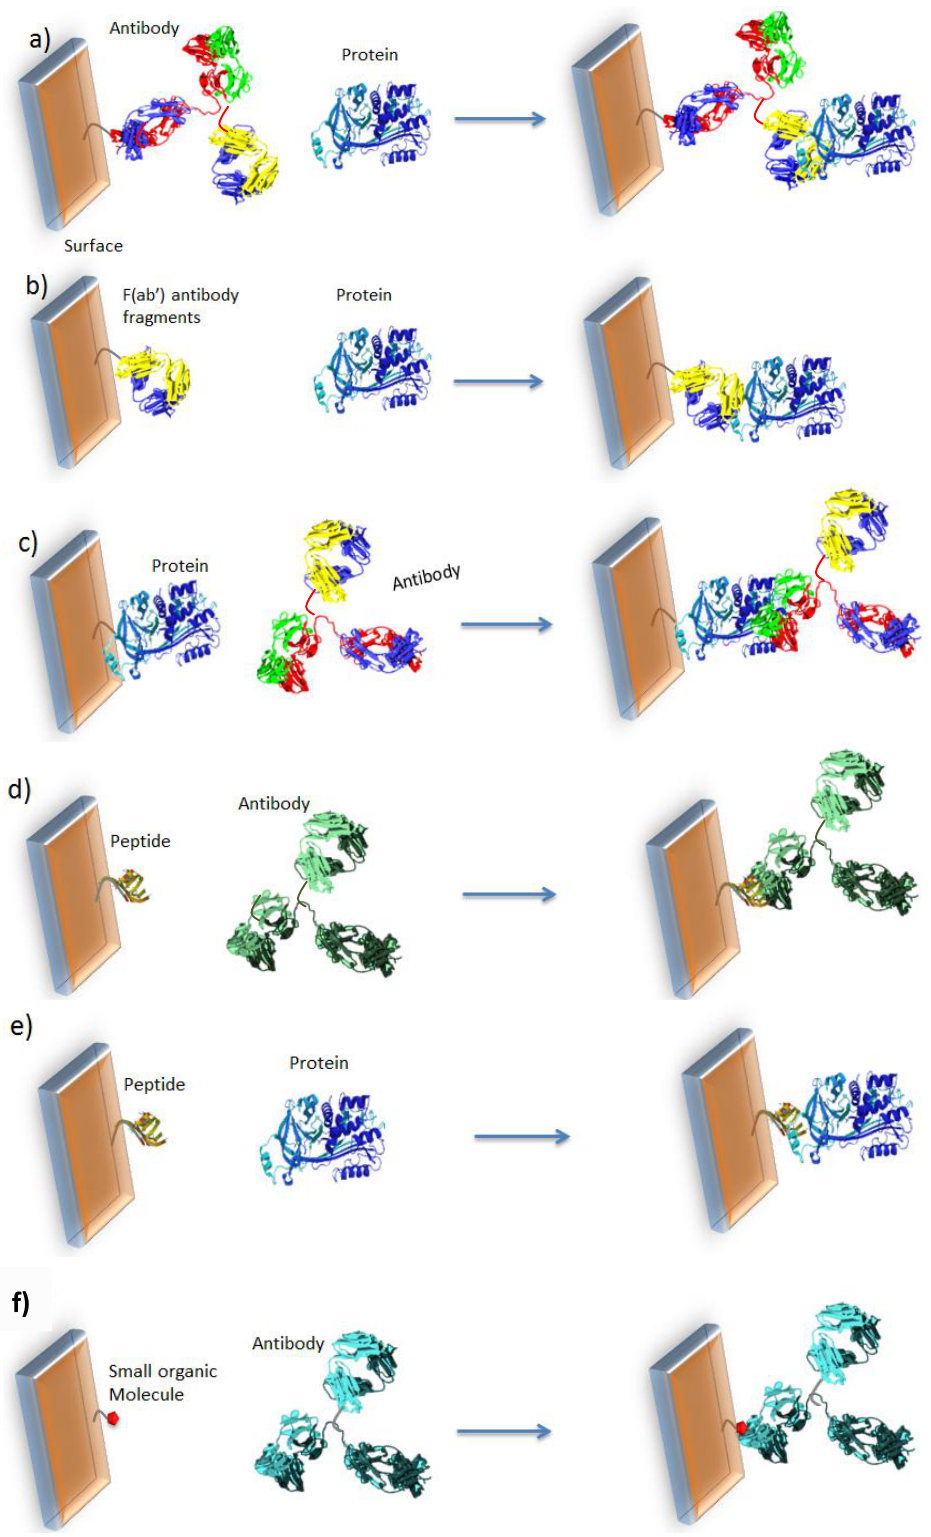
Figure 2. Classical formats used for detections of proteins or antibodies. ( a ) Grafted antibodies (Ab) to detect proteins; ( b ) Grafted antibody fragment F(ab’) to detect proteins; ( c ) Grafted protein to detect Ab. Use of peptides to detect ( d ) antibodies or ( e ) proteins. ( f ) Use of small organic molecules.